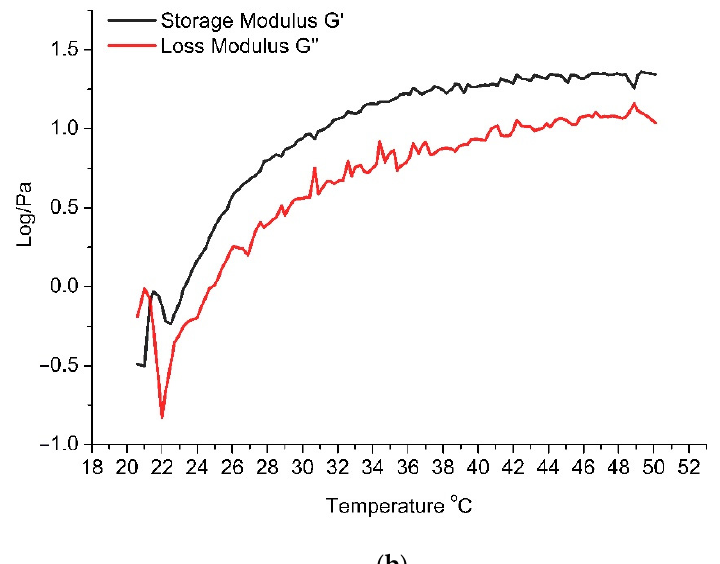
Figure 5. In situ gels’ gelation temperatures (storage modulus(G ′ ), loss modulus (G ″ )). ( a ) G2 gel; ( b ) G6 gel.